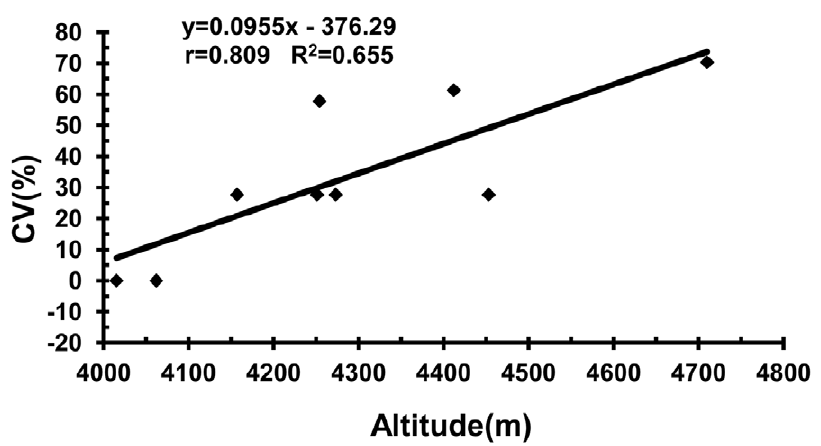
Figure 2. Scatter plot of altitude against CV. Each dot represents a module.